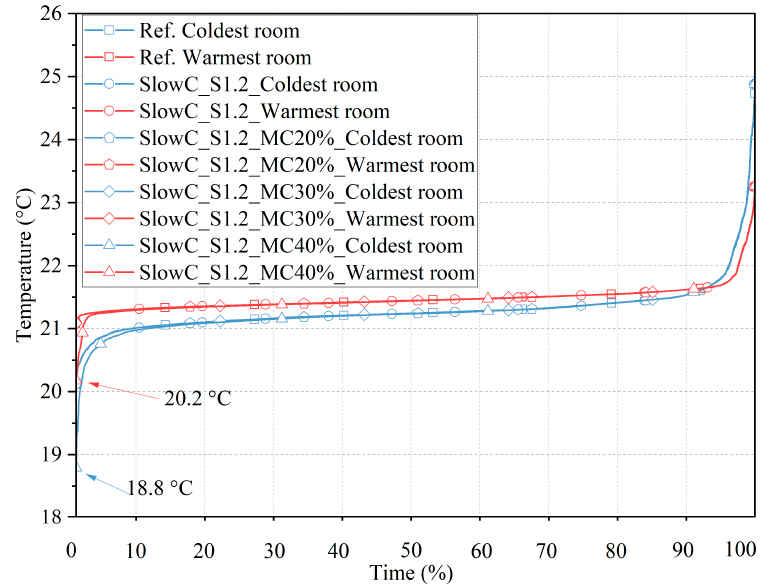
Figure 16. Heating season (14 October–7 May) duration of indoor air temperatures in the coldest and warmest rooms.